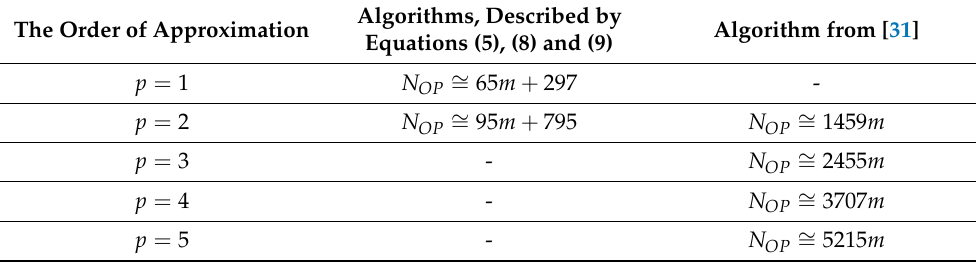
Table 5. The computational complexity of the algorithms, described by Equations (5), (8) and (9), and from